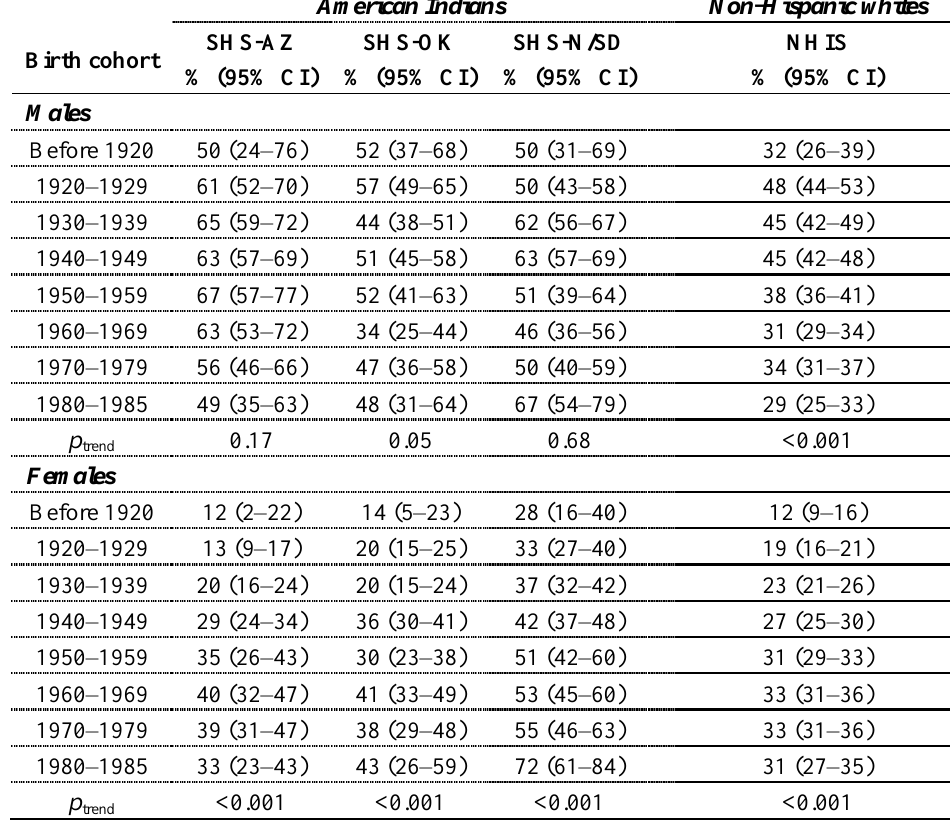
Table 2. Percent of Strong Heart Study (SHS) and National Health Interview Survey (NHIS) participants with smoking initiation age 18 years or younger according to